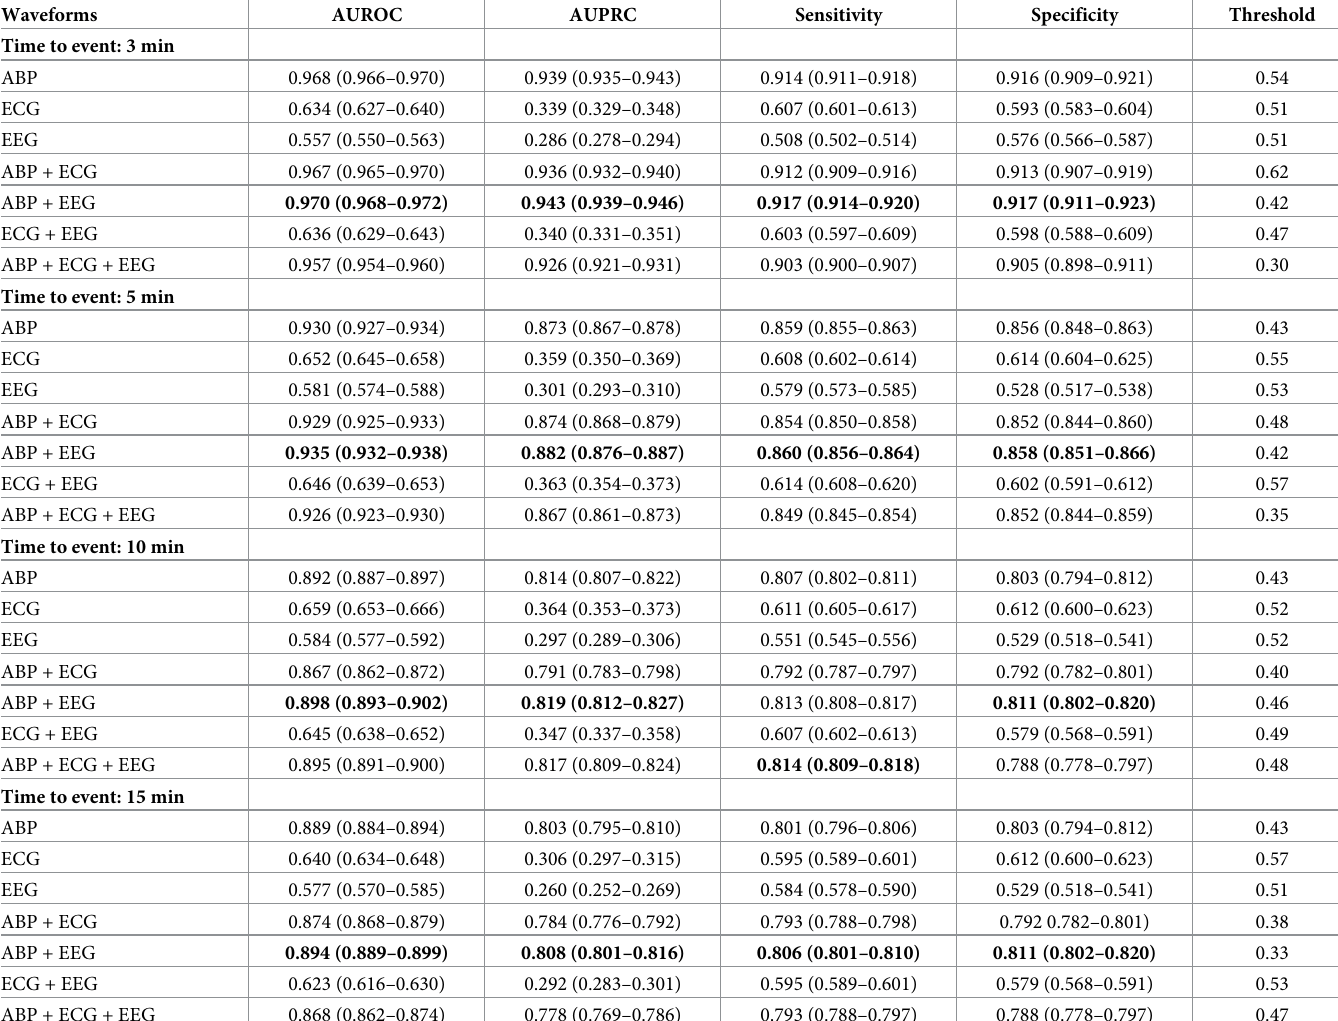
Table 3. Area under the Receiver-operating Characteristic Curve, Area under the Precision-Recall Curve, Sensitivity, and Specificity of our model in predicting intraoperative hypotension. Value (95% confidence interval); AUROC, area under the receiver operating characteristic; AUPRC, area under the precision-recall curve; ABP, arterial blood pressure; ECG, electrocardiogram; EEG,